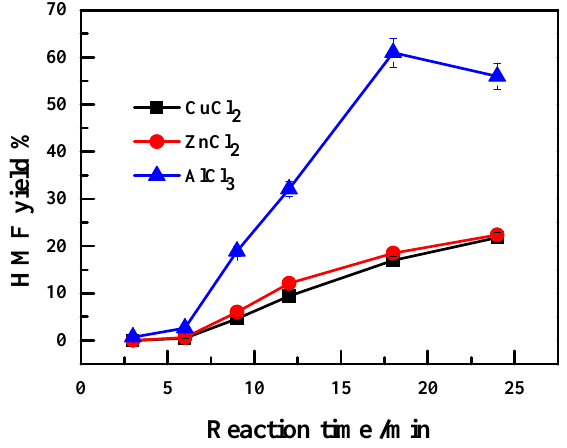
Figure 4. Effect of ionic radii of Lewis acid salts on the yield of HMF. Reaction conditions: reaction temperature of 160 °C, reaction time of 25 min, 0.1 g glucose in 1.5 g 25 mM Lewis acids aqueous solution, 3 g sec-butyl phenol.